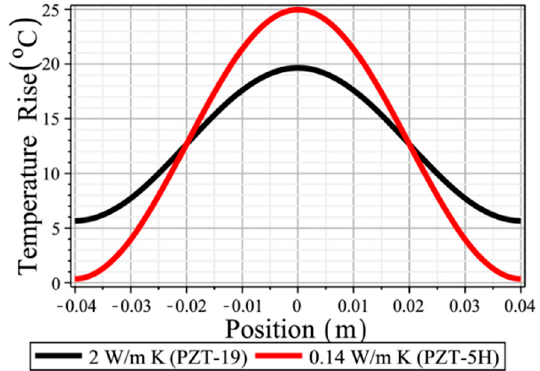
Figure 1. Saturated temperature distribution profile difference between PZT-5H and PZT-19.